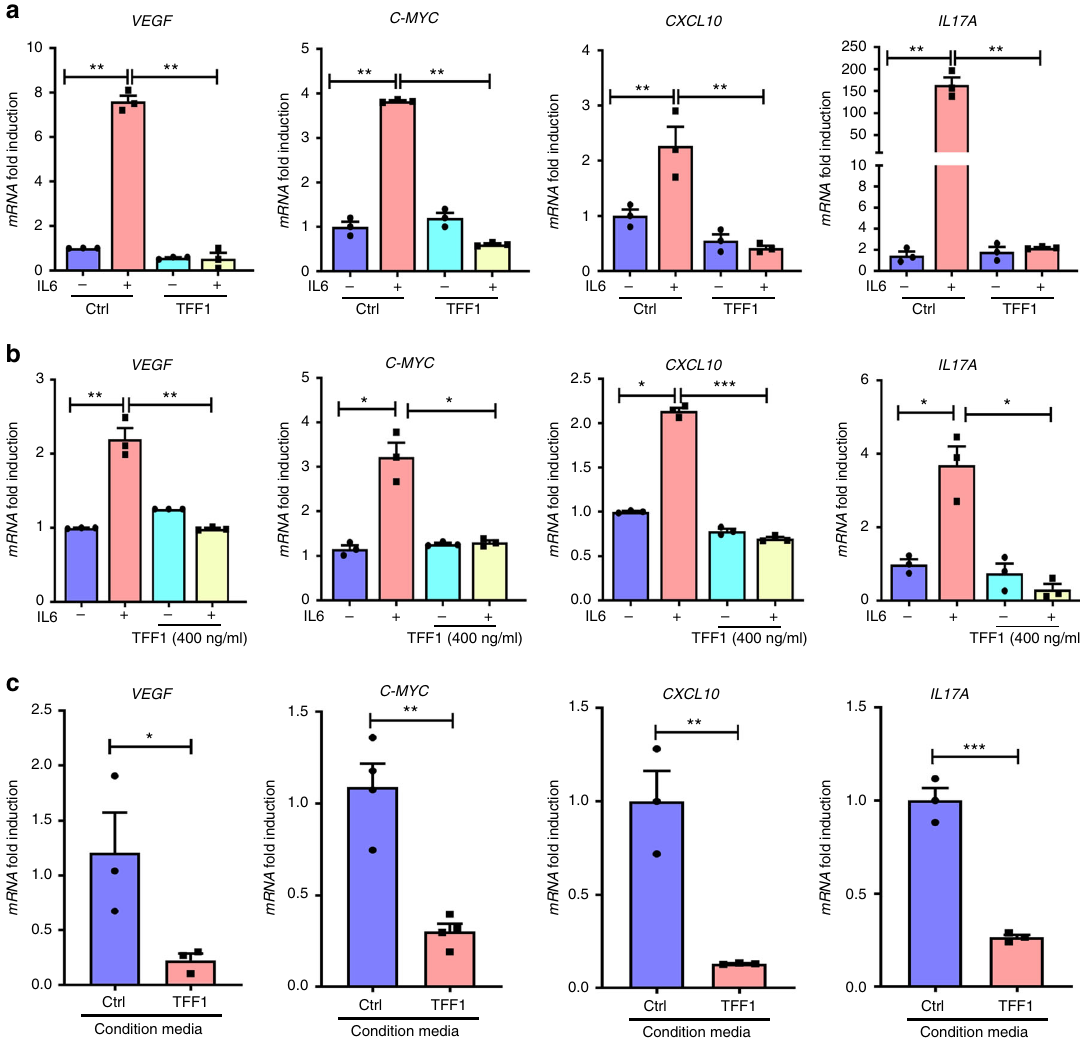
Fig. 5 TFF1 suppresses expression of STAT3 target genes in vitro. a – c Quantitative real-time PCR analysis demonstrated expression levels of several STAT3 target genes ( VEGF , C-MYC , CXCL10 , and IL17A ) in vitro. a AGS cell lines were infected with either TFF1 or control adenoviruses (5 MOI) for 48 h and then treated with or without IL6 (100 ng mL − 1 ) for 2 h. b AGS cells were treated with or without TFF1 recombinant protein (400 ng mL − 1 ) for 24 h and either stimulated or not with IL6 for 2 h. c AGS cells were treated with conditioned media from AGS-pcDNA or AGS-TFF1 stable cell lines for 24 h. The results are expressed as mean ± SEM of at least 3 independent experiments; * P < 0.05, ** P < 0.01 and *** P < 0.001 by two-tailed Student ’ s t test (for two groups) and